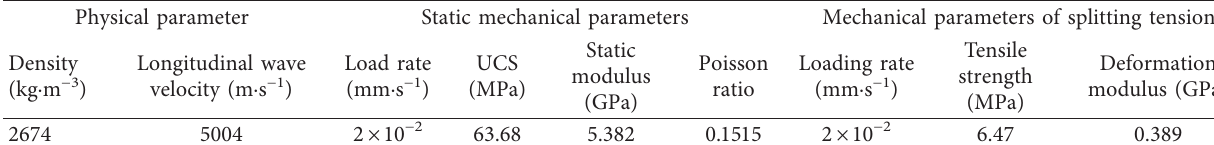
Table 1: Basic static physical and mechanical parameters of limestone specimen.